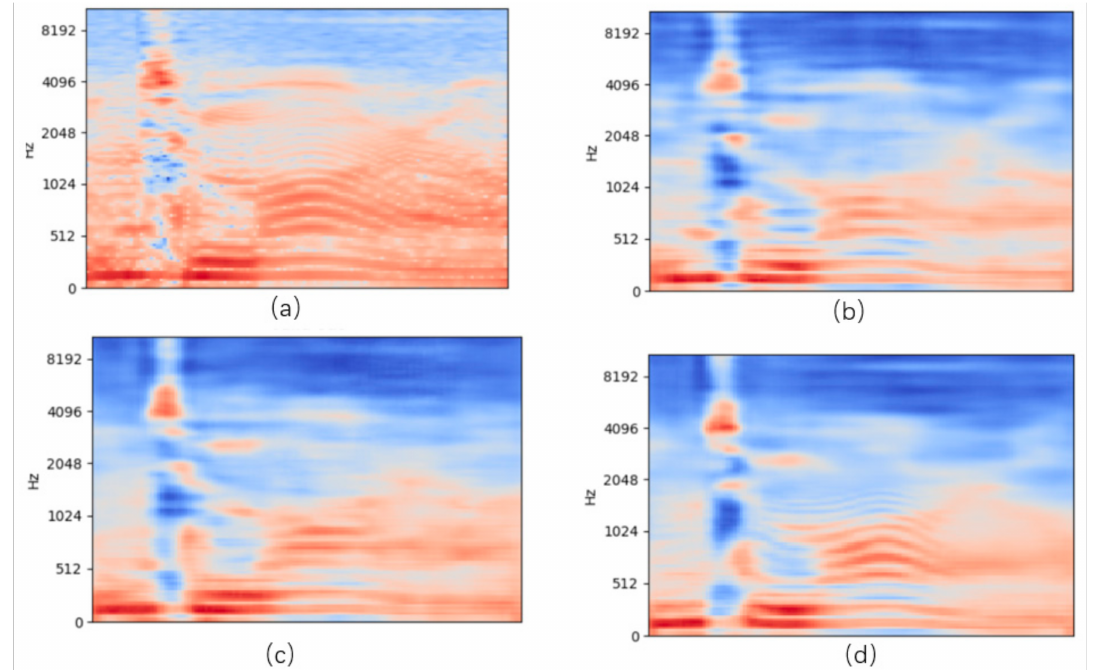
Figure 8. Reconstruction results on LibriSpeech with three autoencoders. The x -axis represents the time table and y -axis represents the frequency. ( a ) Input log Mel-spectrogram, ( b ) Simple AE, ( c ) DAE, ( d )